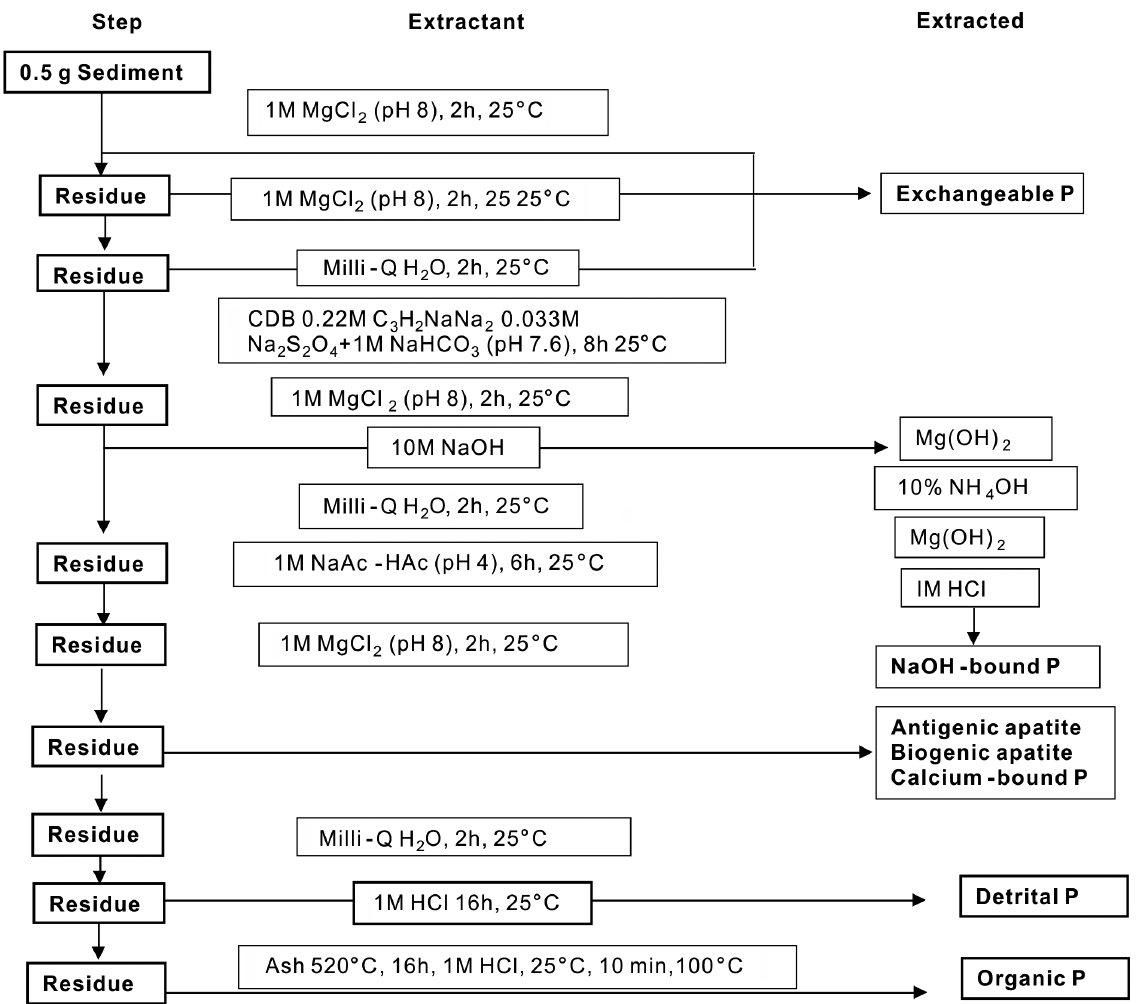
Fig. 1. Phosphorus (P) fractions extraction procedure (SEDEX) for aquatic surface sediments, modified from Ruttenberg (1992) and Yang et al.